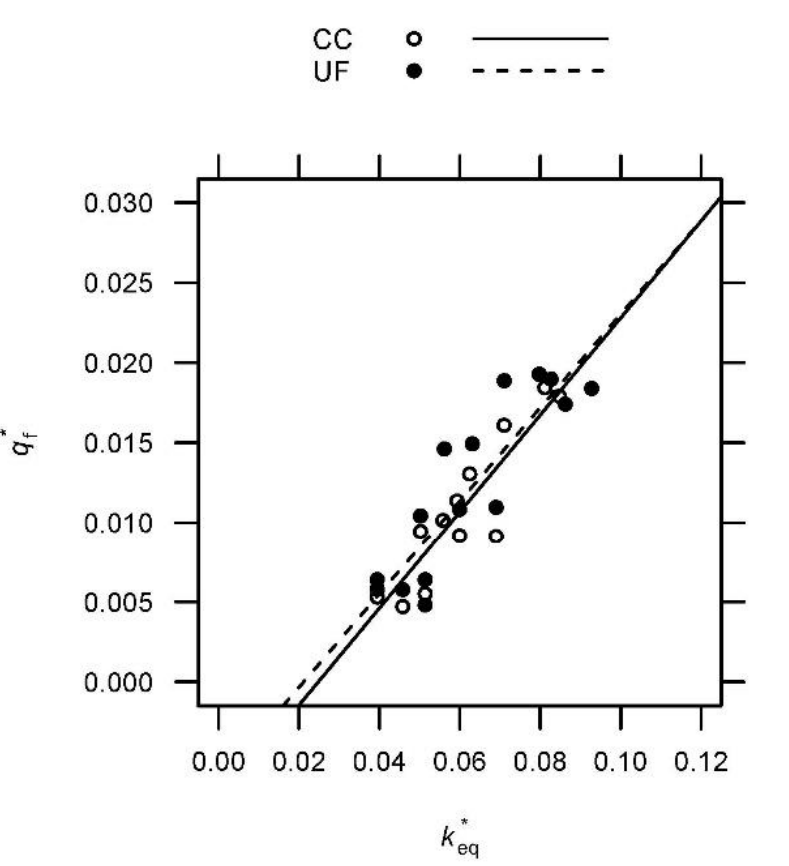
Figure 18. Variation of 𝑞 f∗ with 𝑘 eq∗ differentiating by the impervious element (Central Core and Upstream Face).